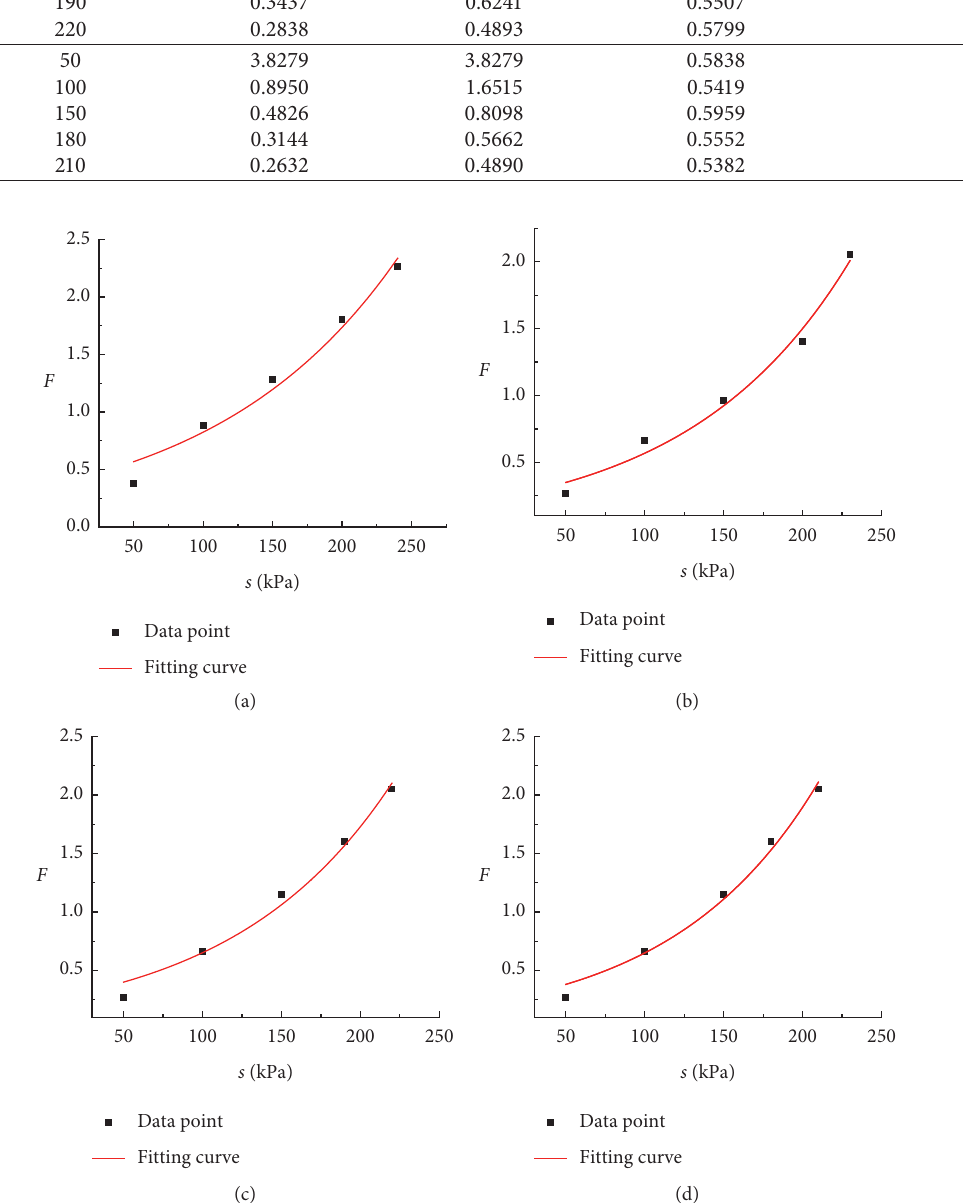
Figure 10: Relationship between F and deviatoric stress under different initial static deviatoric stresses. (a) q � 0 kPa, (b) q � 10 kPa, (c) q � 15 kPa, and (d) q � 20